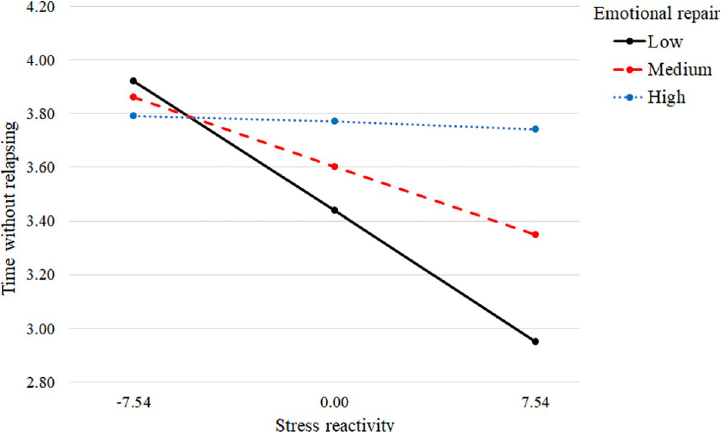
Fig 3. Conditional effect of stress reactivity on time without relapsing at low, medium, and high values of emotional repair acting as moderator. Values on the y-axis represent the amount of time without relapse, where 1 equals less than 3 months without relapse and 5 equals the whole follow-up without relapse (12 months). Values on the x-axis represent mean-centered levels of stress reactivity. The table shows indirect effects, standard errors, and 95% confidence intervals for each Emotional repair